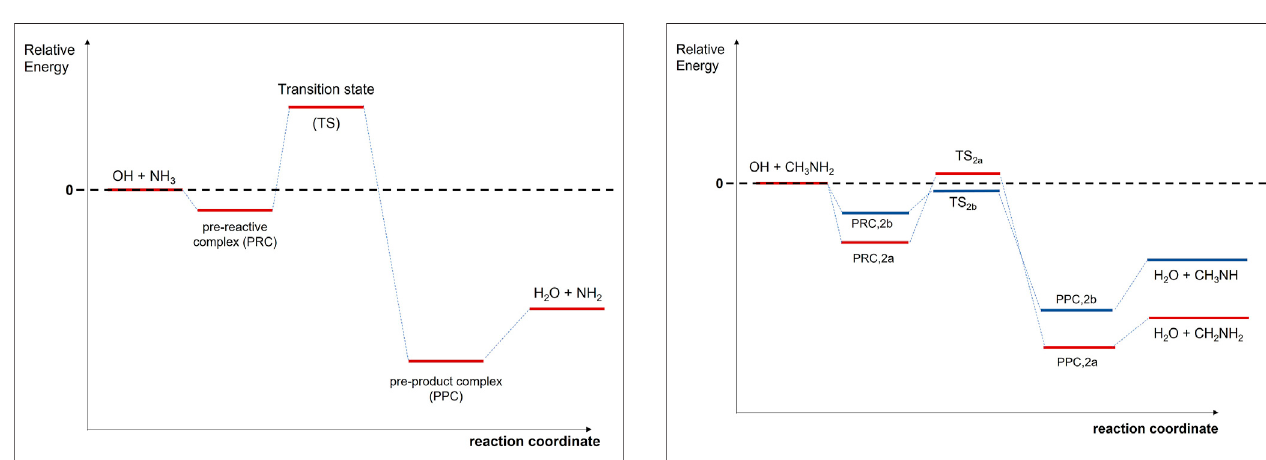
SCHEME 1 | Simpli fi ed reaction energy pro fi le along the MEP for the OH + NH 3 reaction.